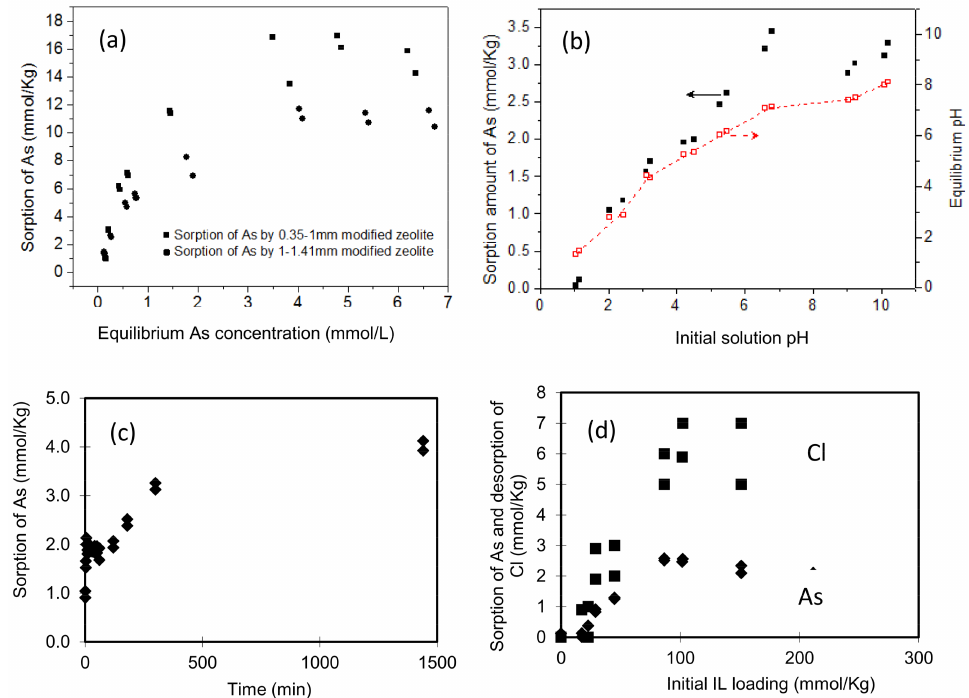
Figure 5. Arsenic sorption isotherm on ILMZ of different particle sizes ( a ); as a function of initial pH (solid symbols with left Y -axis) and equilibrium solution pH (open symbols with right Y -axis) ( b ); and affected by contact time ( c ); and the effect of initial IL loading on As ( (cid:7) ) sorption and counterion Cl ( (cid:4) ) desorption ( d